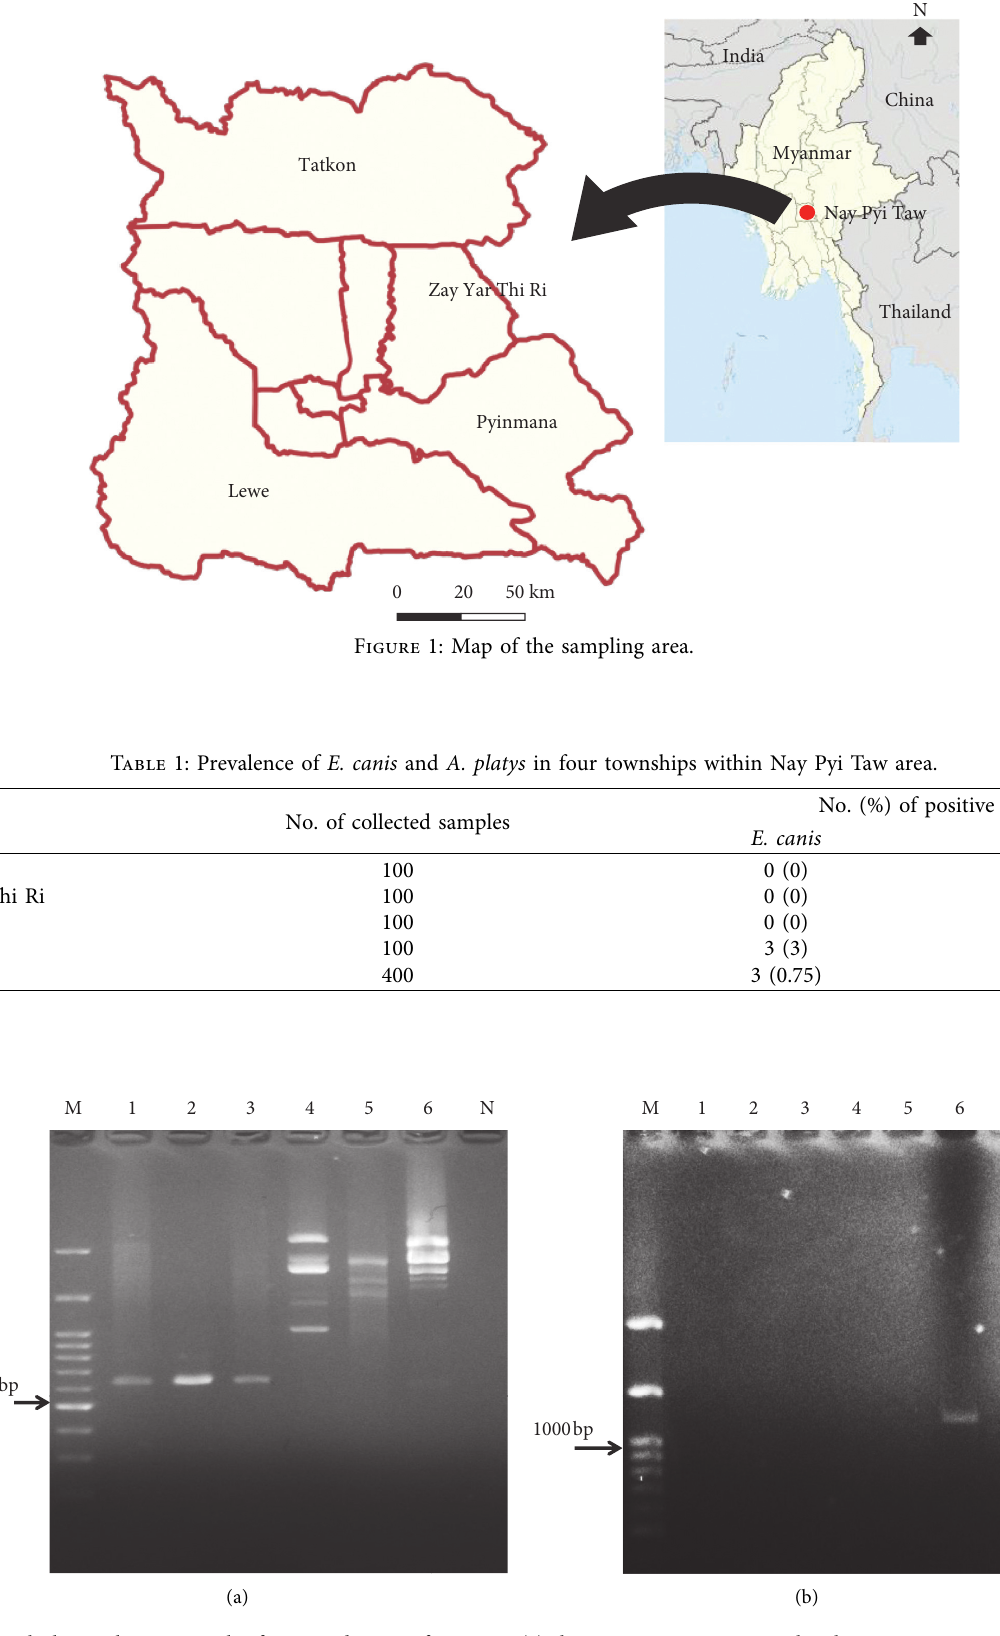
Figure 2: Gel electrophoresis results for nested PCR of E. canis (a): lanes 1–3 � positive samples, lanes 4–6 � negative samples, and N � negative control, and A. platys (b): lane 6 � positive, lanes 1–5, and 7 � negative samples, and N � negative control; M � 100bp marker.